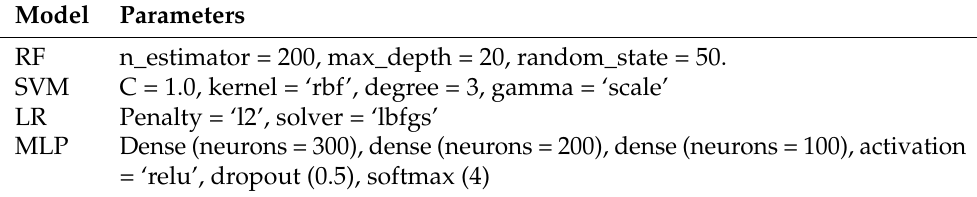
Table 2. Hyperparameters for the machine learning